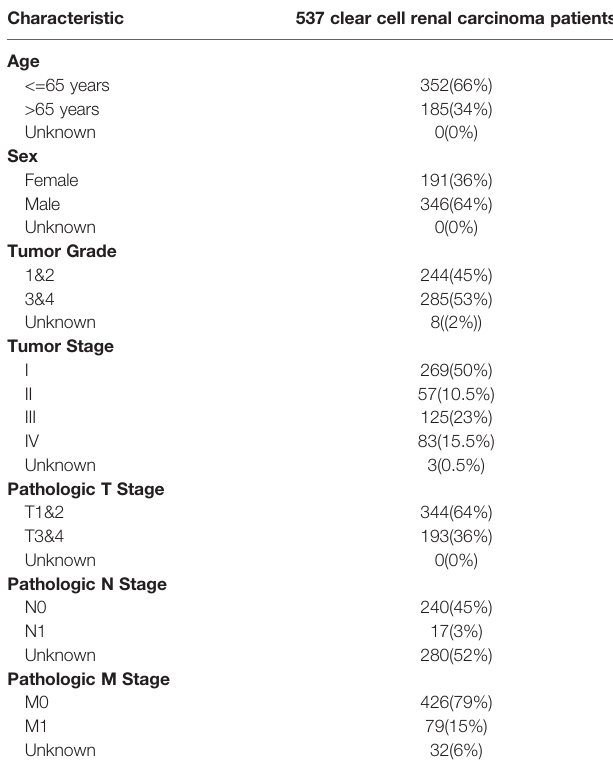
TABLE 1 | Baseline patient characteristics (n =